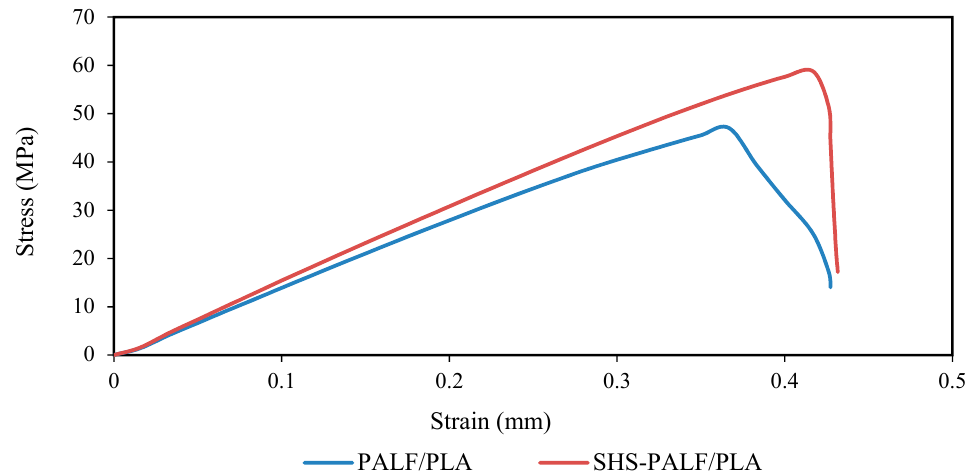
Figure 3. Typical tensile curves for PALF/PLA and SHS-PALF/PLA biocomposites.